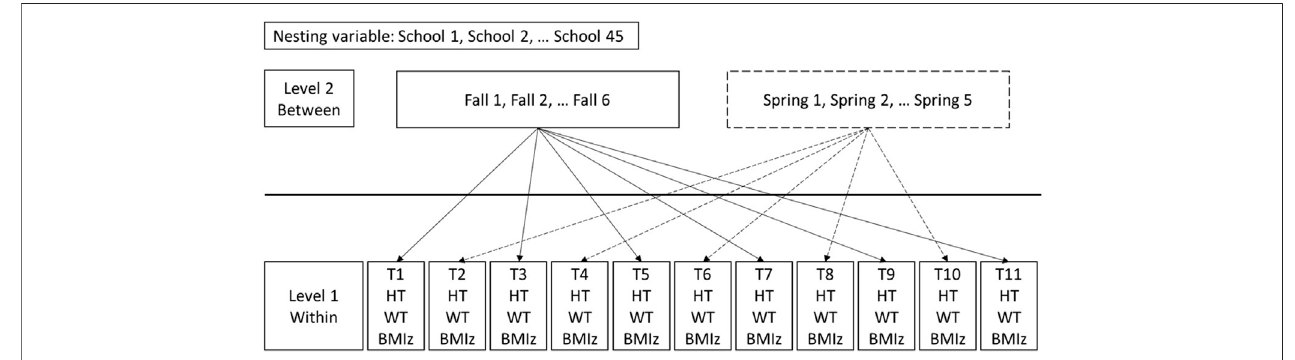
FIGURE 1 | Mixed effect model